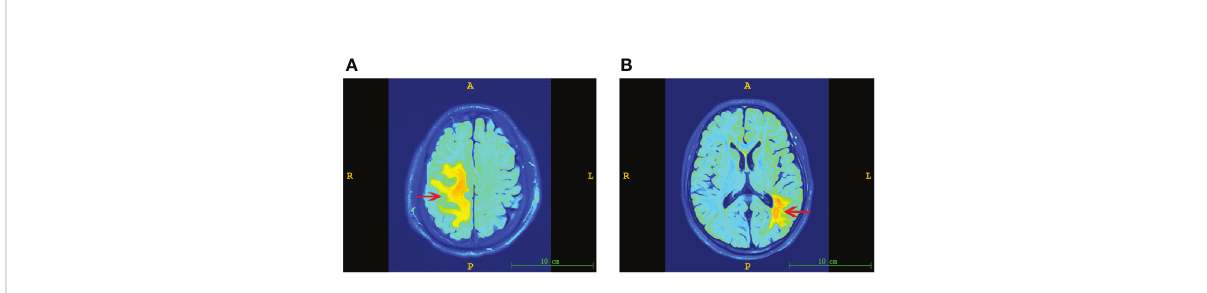
FIGURE 4 Representative MR images of cerebral lesions of varying size in PACNS patients. Dominant lesions are marked by arrows. (A) Image of a larger lesion showing hyperintense regions on FLAIR imaging. (B) Image of a smaller lesion observed on FLAIR imaging.